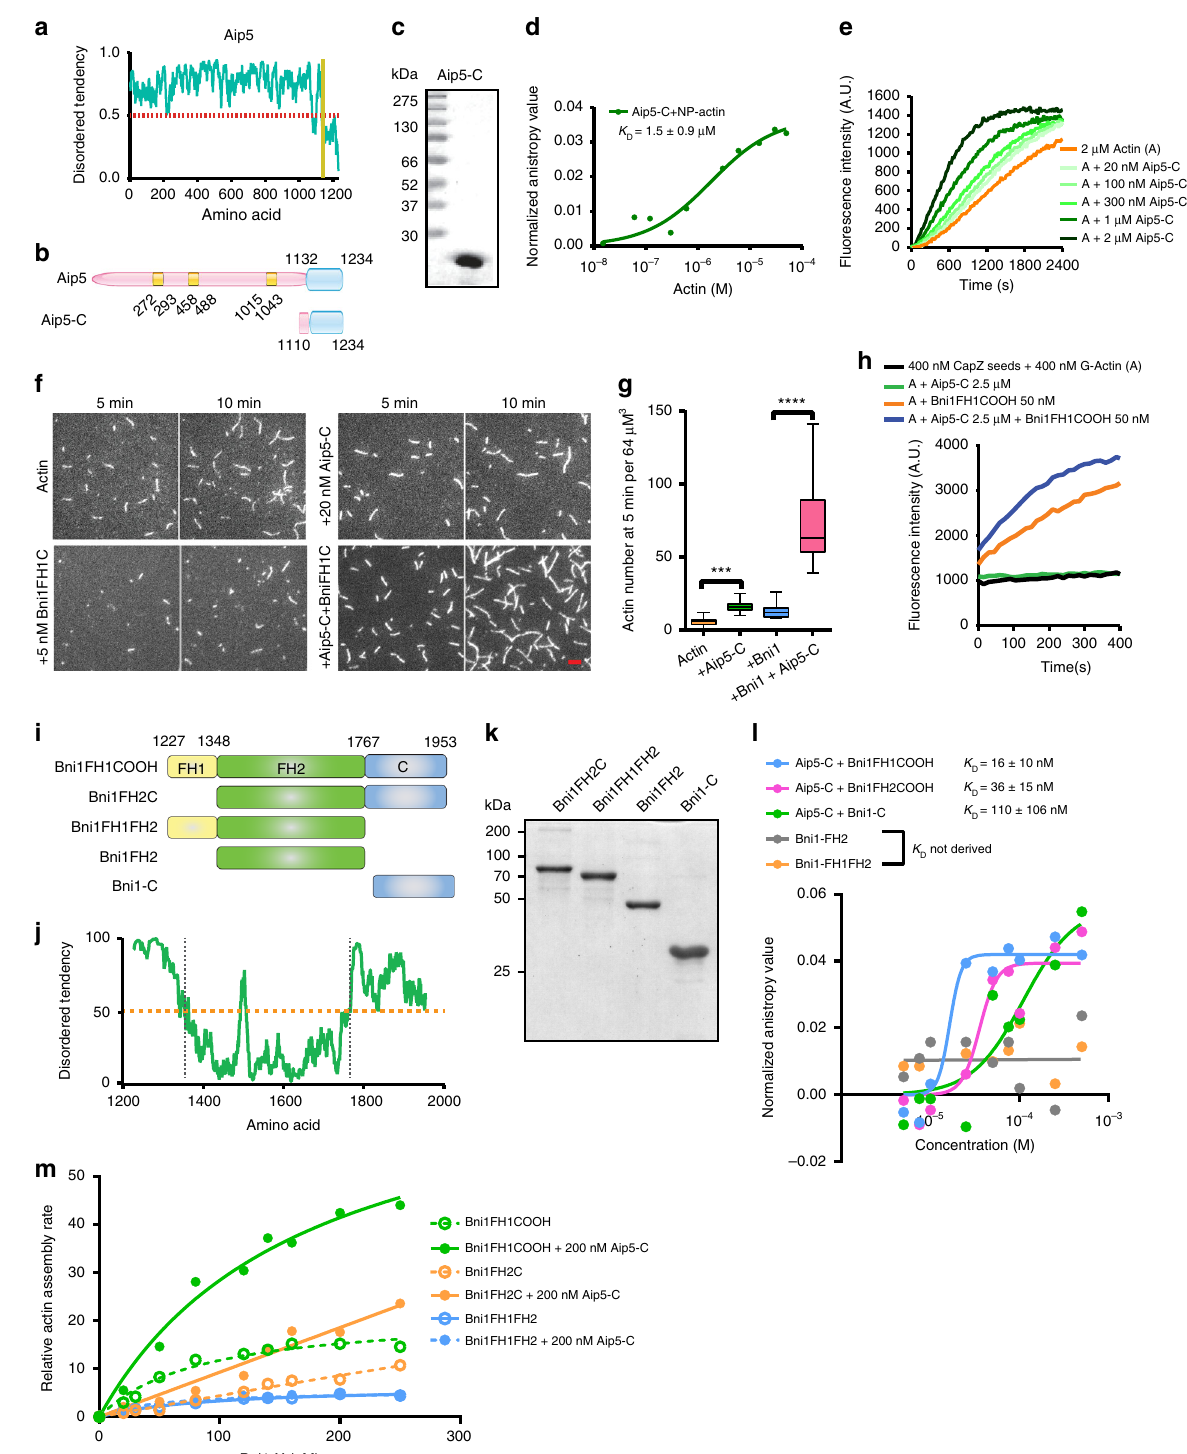
the polymerization rate (Fig. 3k). Notably, the additional S1165C and N1162A mutations to L1150A (Aip5-C-3m) resulted in complete suppression of the actin assembly activity of Aip5-C (Fig. 3k and Supplementary Fig. 3e). To understand the consequences of the triple mutation, Aip5-C-3m was crystallized, and the structure was determined through molecular replacement using the native Aip5-C structure as the search model. NATURE COMMUNICATIONS| (2019) 10:5078